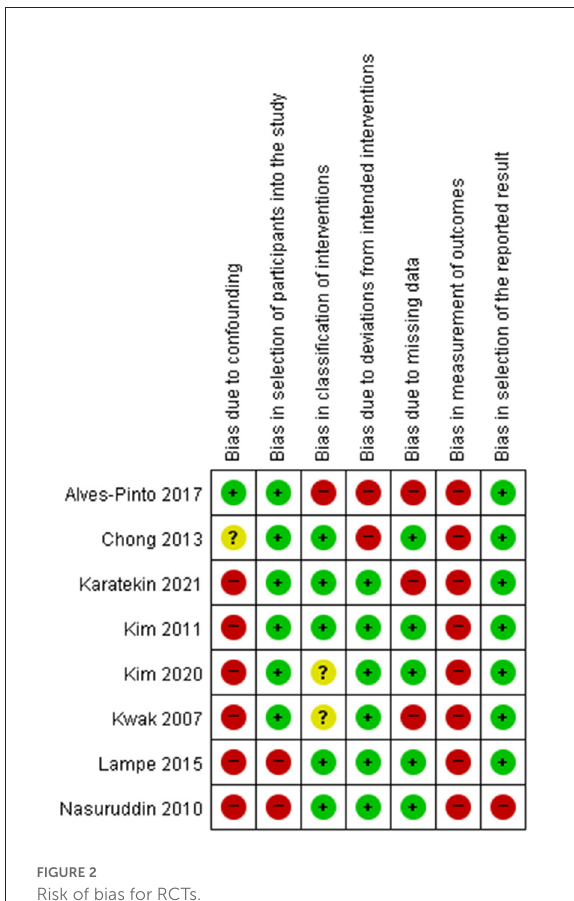
FIGURE2 Risk of bias for RCTs.